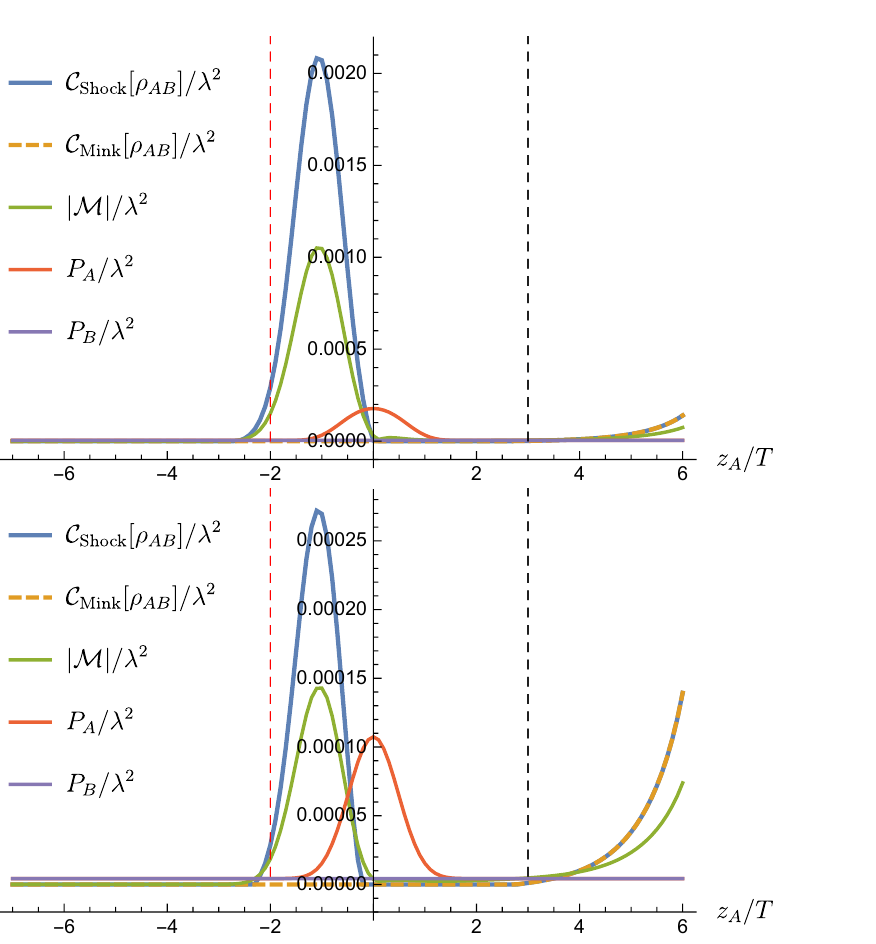
Figure 4 . Concurrence, non-local correlation and local noise contributions for two detectors. The plots show the concurrence between Alice and Bob’s detectors and the corresponding local/non-local contributions as a function of Alice’s position. We show the concurrence for Minkowski space (orange dashed curve) as a reference. For both plots, the shockwave is localized at u = 0 , Bob is fixed at z B = 7 T , and Alice’s position z A is varied. We set Ω T = 3 . 75 . Top: shockwave with nonzero trace, i.e, a x T = a y T = 1 . Bottom: traceless shockwave a x T = − a y T = 1 . In each case the vertical dashed line in red marks the position of Alice’s detector where the shock begins to alter the excitation probability P A , thus Alice has not crossed the shock for z A . − 2 T . The vertical dashed line in black marks the position of Alice’s detector when the (effectively compact) support of Gaussian switching begins to cross causal future/past of Bob’s detector, thus allowing both detectors to communicate via the quantum field. This manifests as increase in concurrence for z A & 3 T